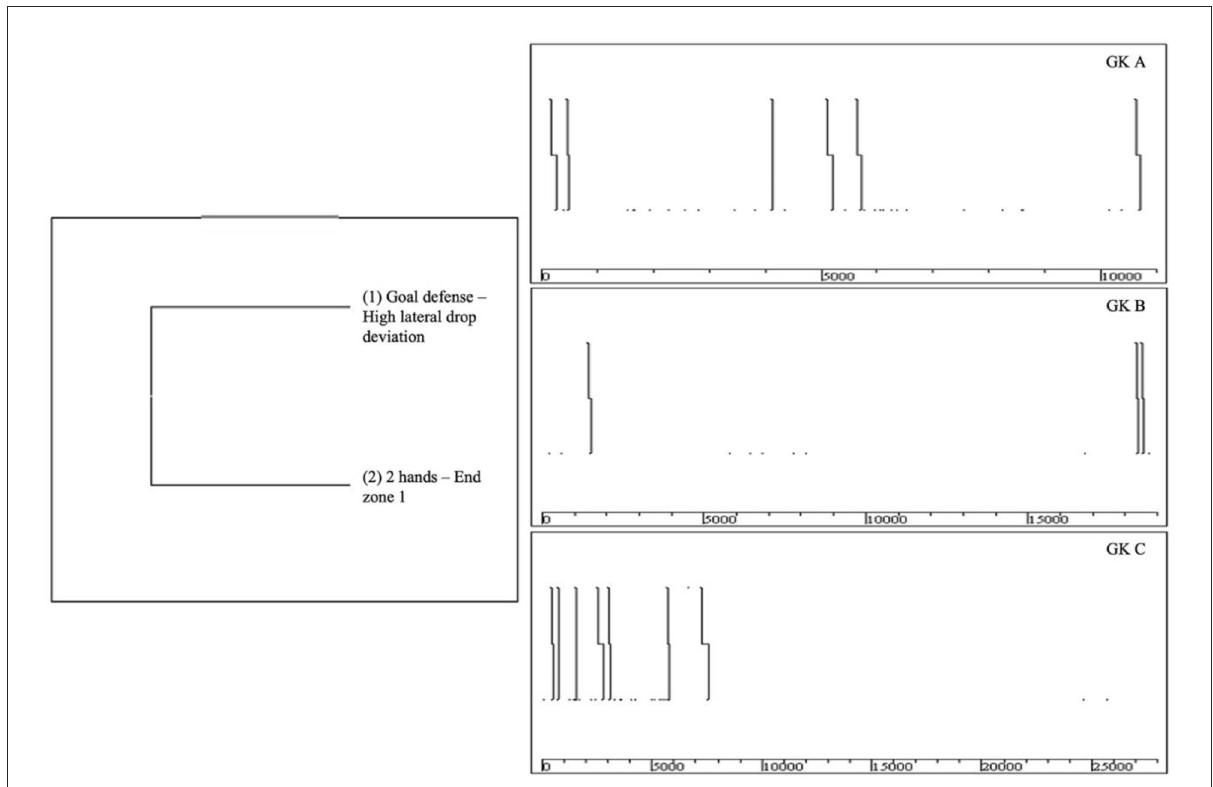
FIGURE3 T- patterns of defensive